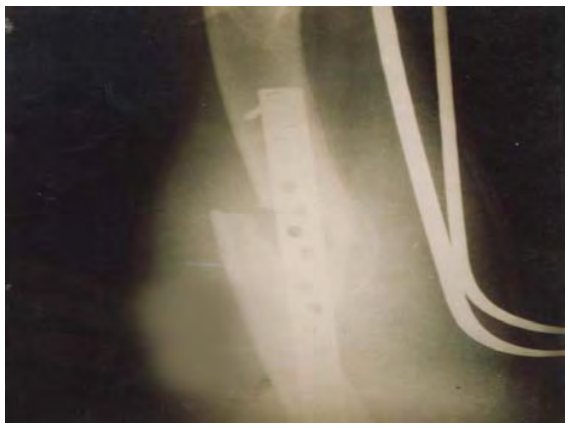
Photo 3: X-ray showing pre-operative antero- posterior